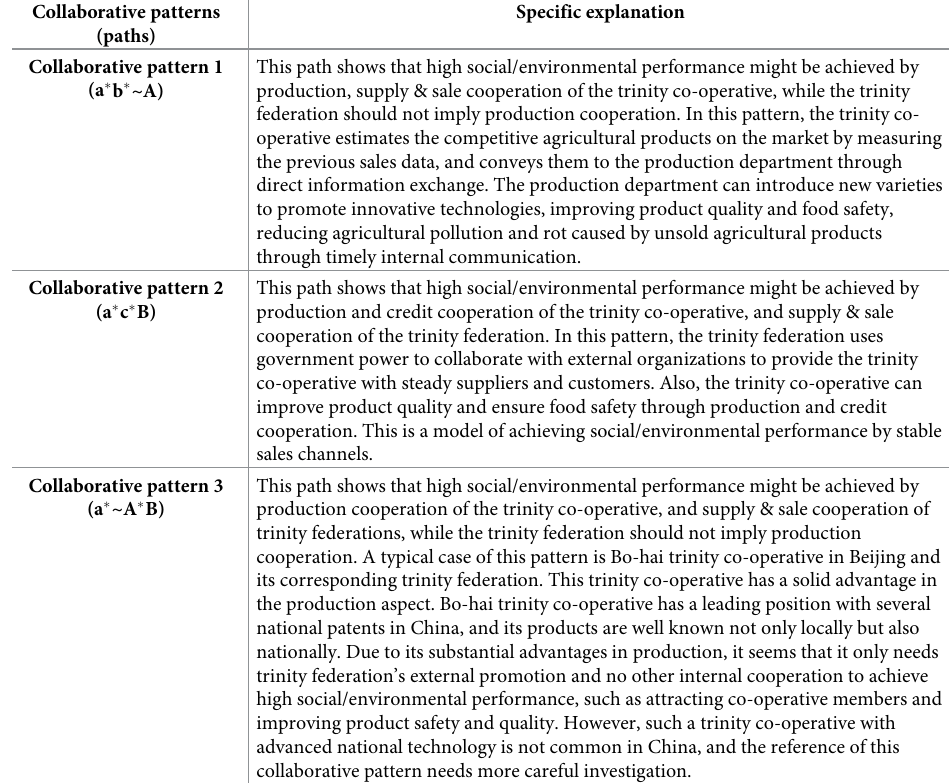
Table 8. The specific analysis of collaborative patterns to “high social/environmental